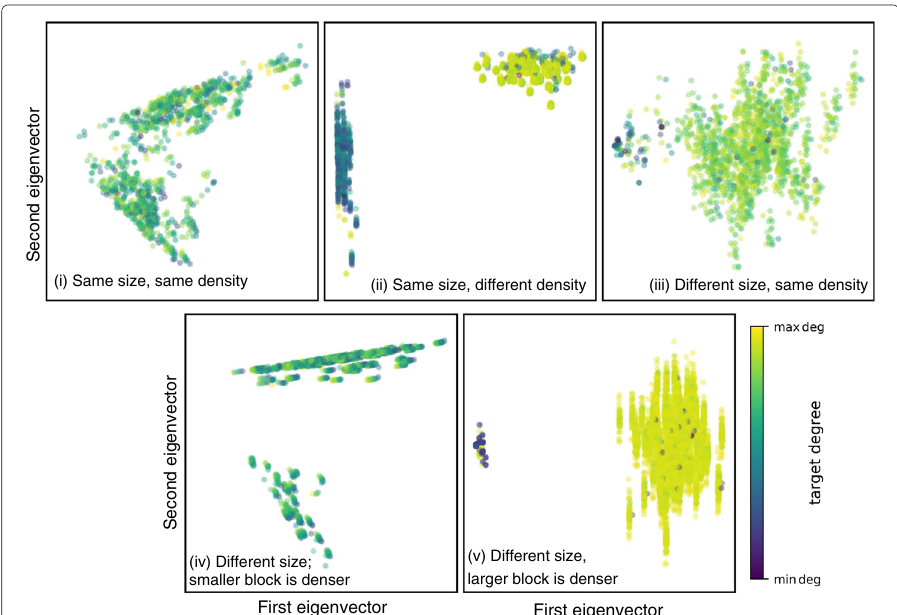
Fig. 15 NBED of stochastic block model graphs. Embeddings of five random graphs generated from the stochastic block. Each graph is connected, has n = 150 nodes and was generated with two blocks; the edge density joining the two different blocks is 0.01. We present five different realizations, depending on the relative sizes and densities of the blocks